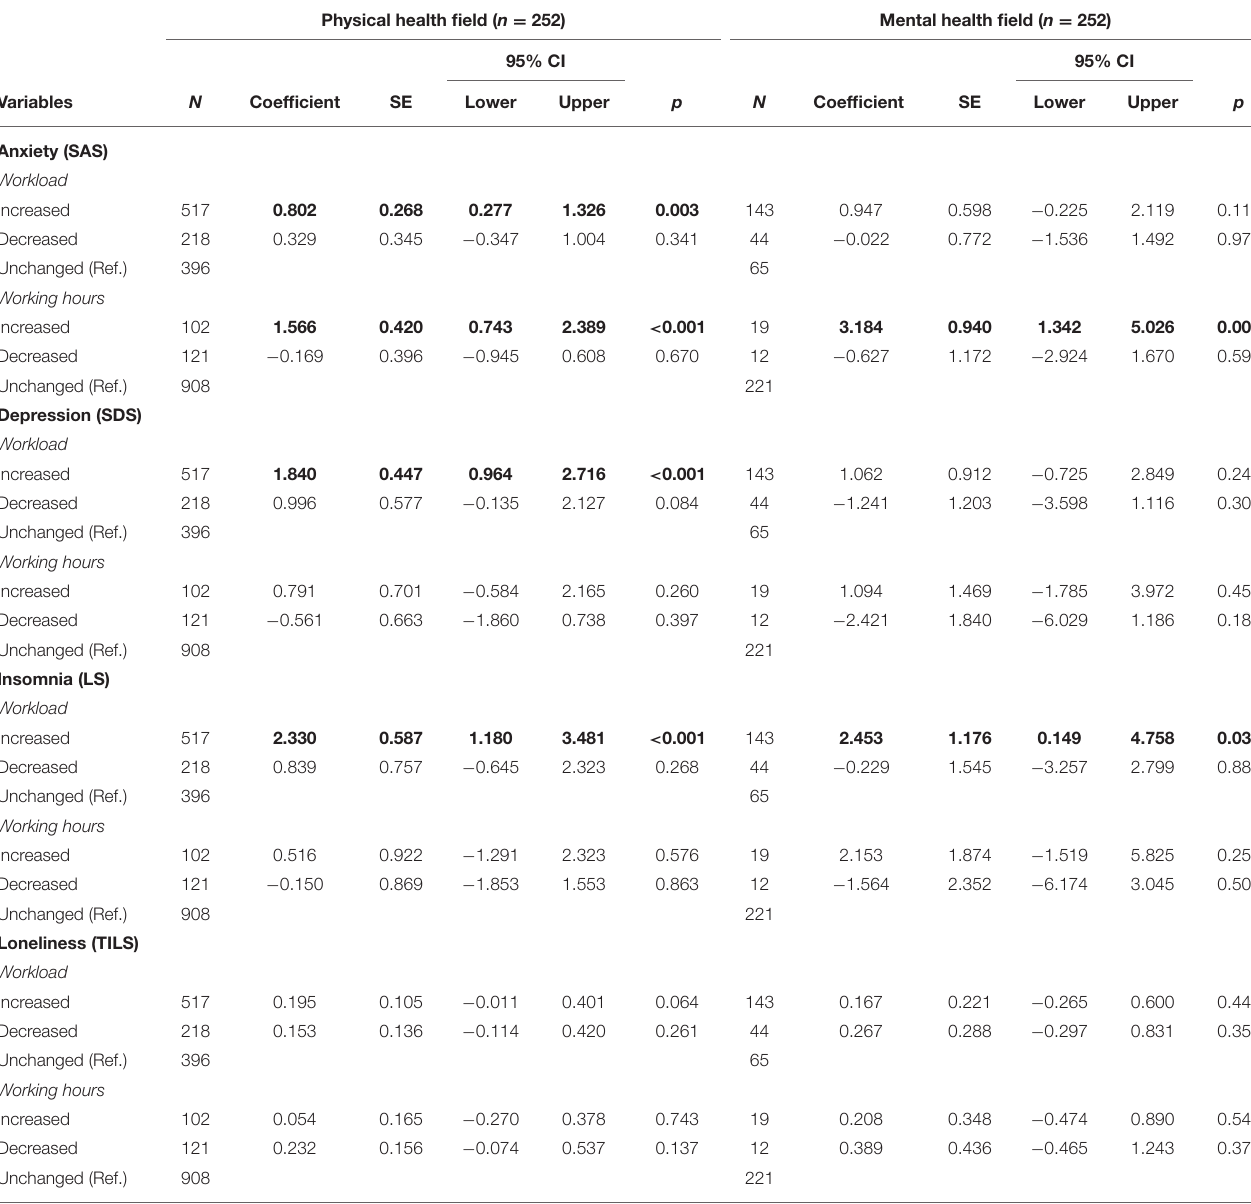
TABLE 4 | Generalized linear model (GLM) for impact of workload and working hours on psychological measurements among occupational